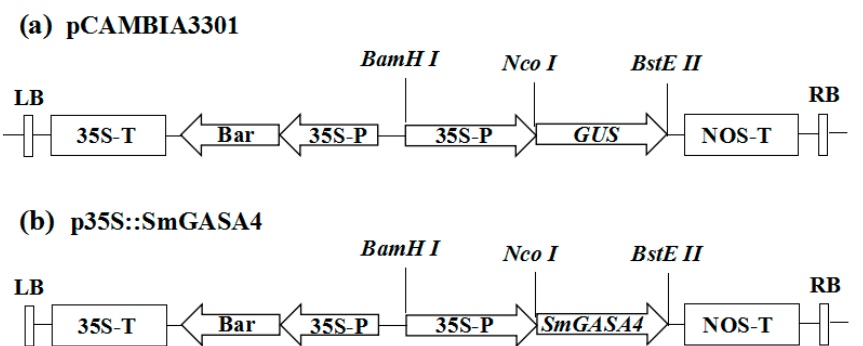
Figure 5. T-DNA regions of the binary plasmids used for Agrobacterium tumefaciens-mediated transformation, as follows: ( a ) Construct of the binary vector pCAMBIA3301, and ( b ) p35S::SmGASA4 binary plasmid containing Bar and SmGASA4, driven by the 35S promoter, 35S-P; the cauliflower mosaic virus-CaMV35S RNA promoter, 35S-T; CaMV35S poly A; NOS-T, the 3 ′ terminator region of the nopaline synthase; Bar; phosphinothricin (R). RB—right border; LB, left border.